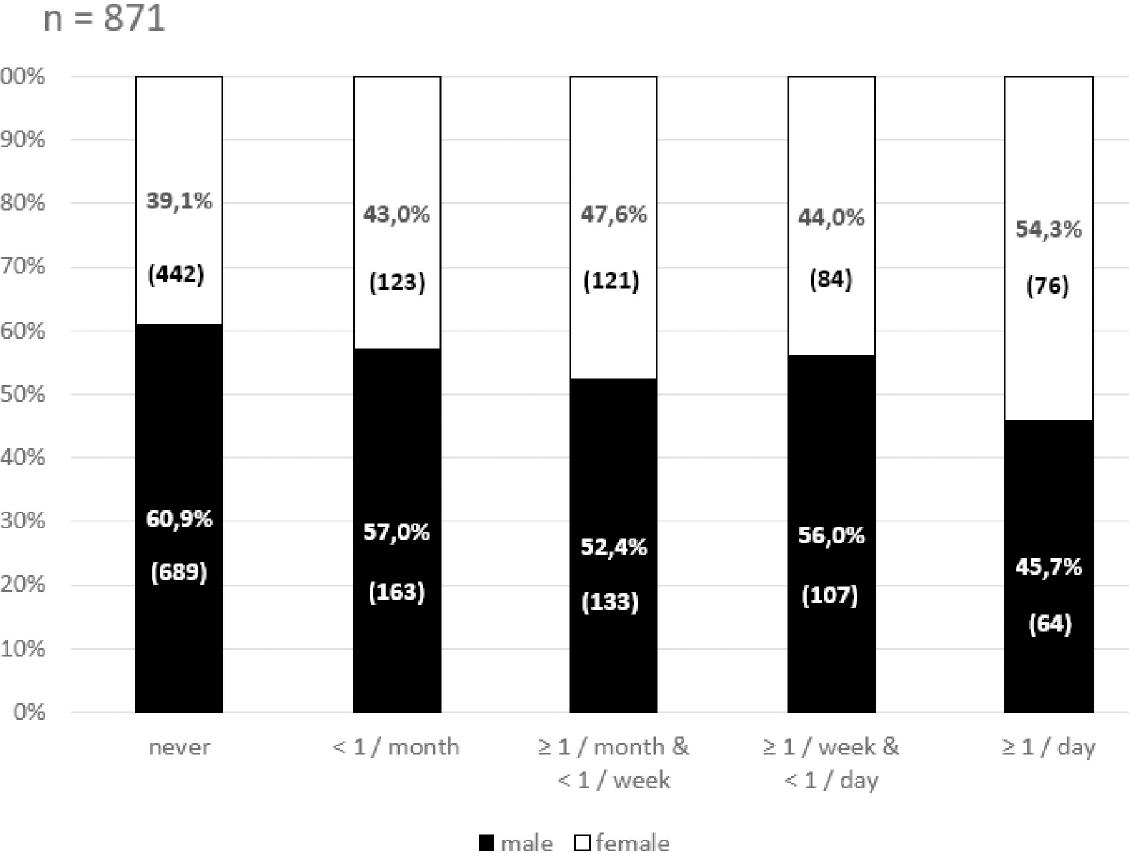
Fig 2. The frequency of GERD-related symptoms is positively associated to female sex (R 2 = 0.75, P = 0.0049). Similar association was found if only the typical symptoms were assessed.